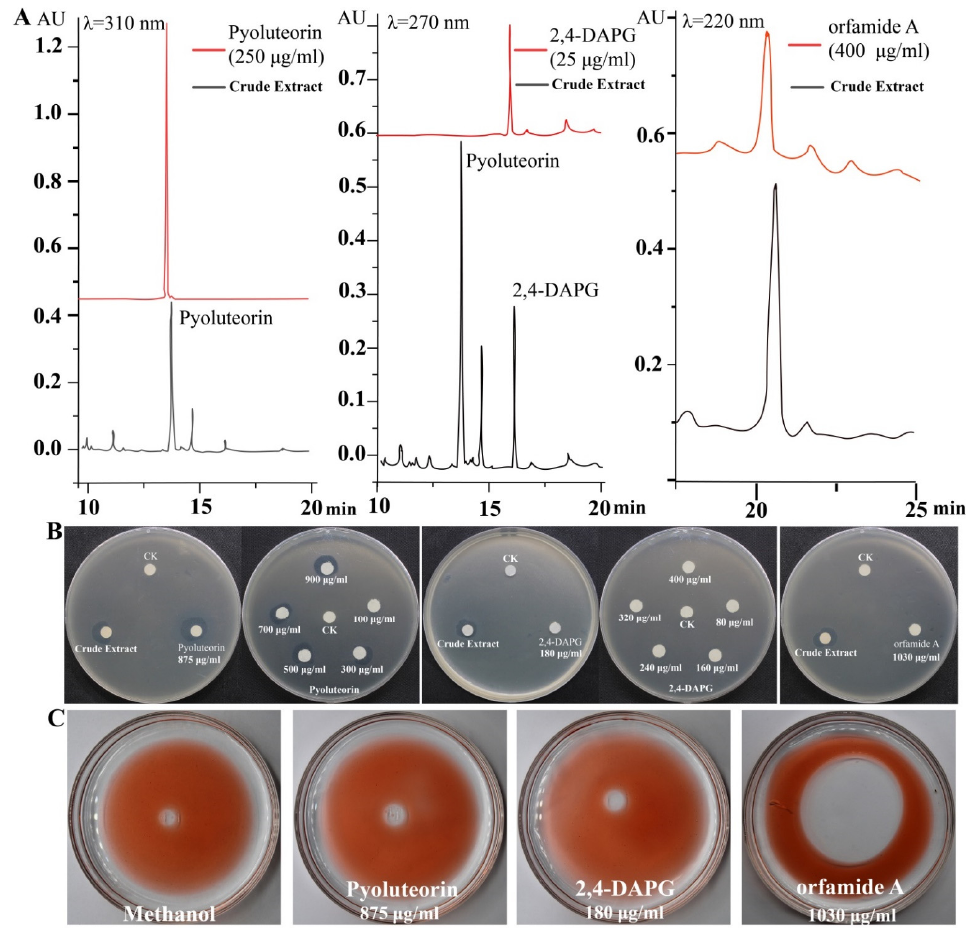
Figure 2. HPLC analysis of the major components in the crude extract ( A ) and detection of their antibacterial activity ( B ) and biosurfactant activity ( C ).